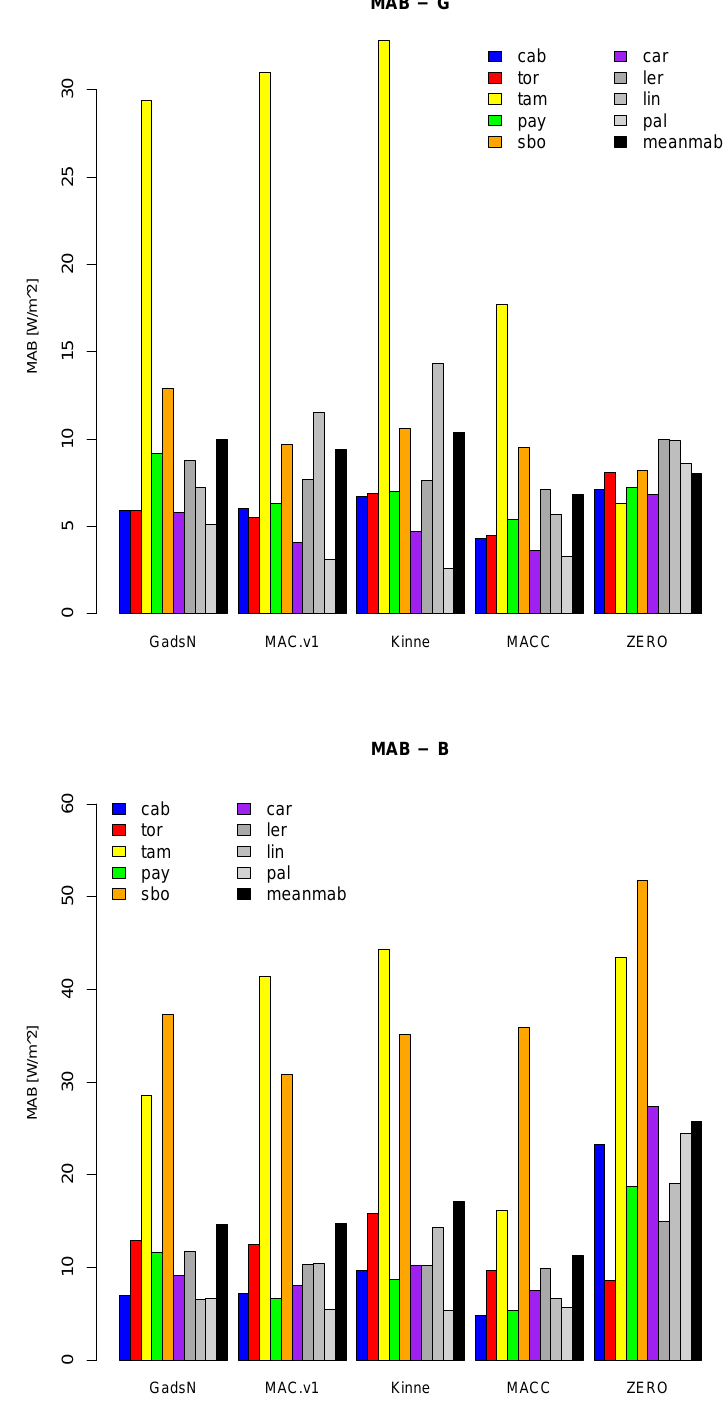
Figure 2. Mean Absolute Bias (mean absolute difference) of the global irradiance (MAB-G, top ) and the direct irradiance (MAB-B, bottom ) for the investigated aerosol climatologies evaluated at nine different Baseline Surface Radiation Network (BSRN) stations (colored bars). “meanmab” is the mean MAB over all nine stations. The effect of aerosols on direct irradiance is much more pronounced. As a result much higher errors are apparent for direct